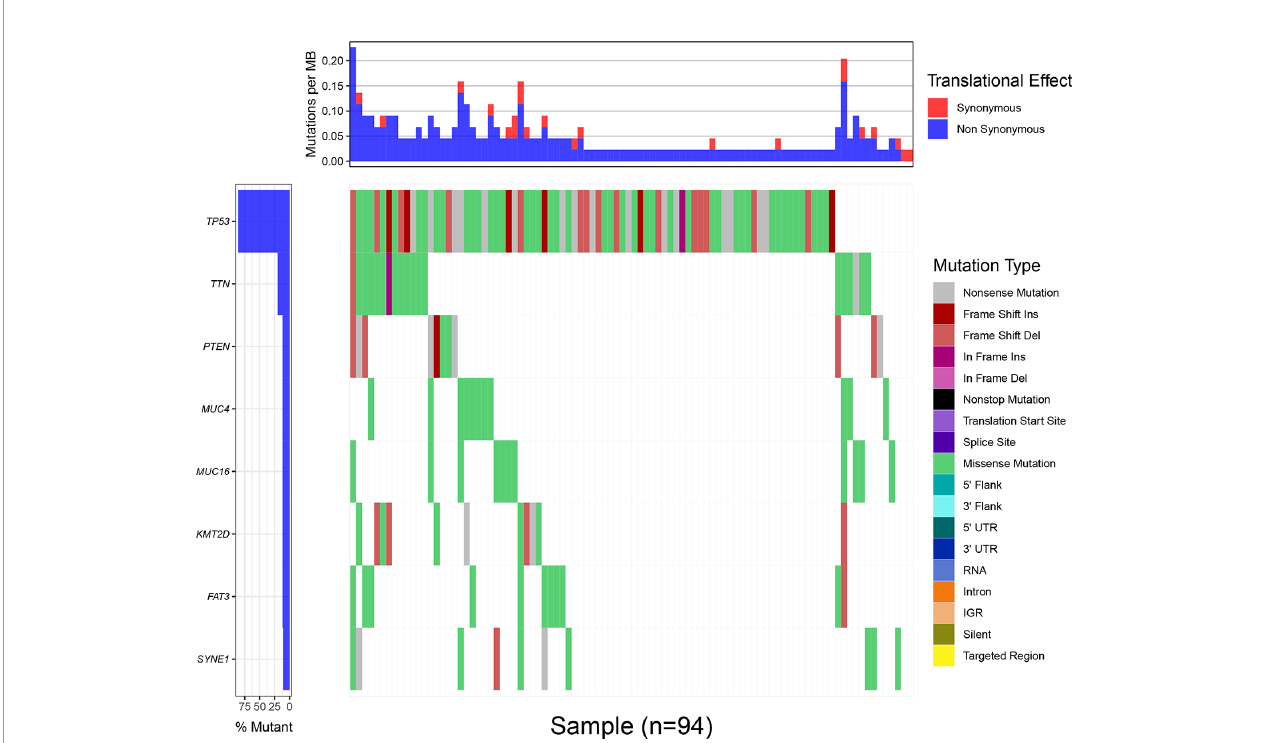
FIGURE 1 | The waterfall map of mutation information of genes in different samples, and different colors represent different types of mutations, showing that only 94 samples out of 101 TNBC mutation samples contained one or more target gene mutations. The upper bar chart shows each MB of each sample Mutation rate, red represents synonymous mutation, blue represents non-synonymous mutation.